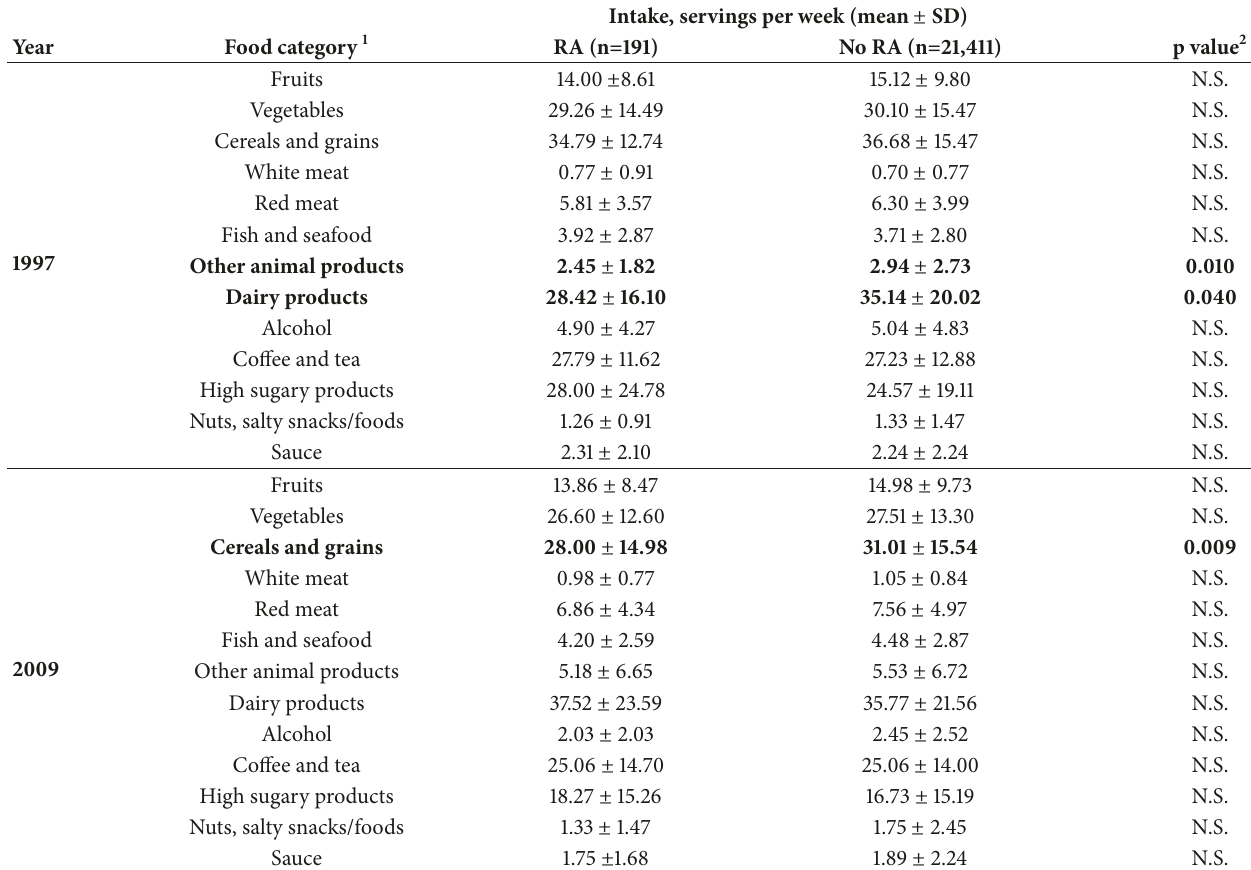
Table 2: Dietary mean intake among women with RA and without RA in 1997 and